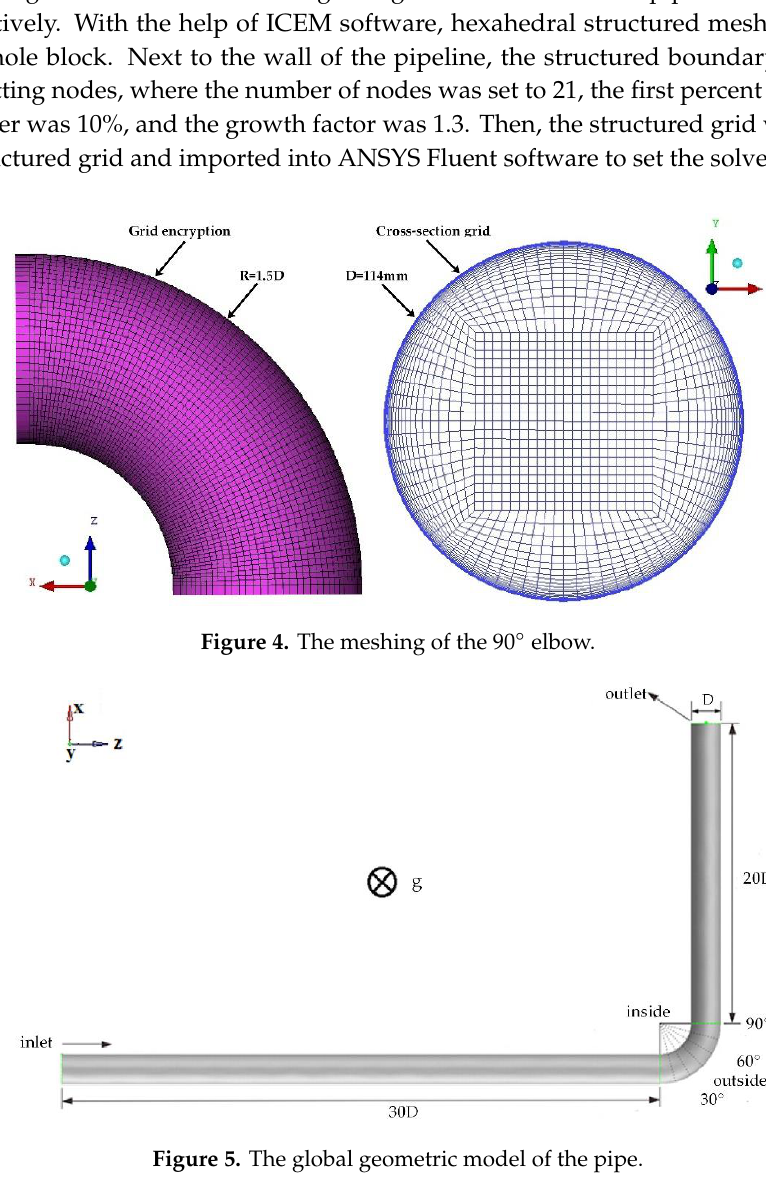
Figure 5. The global geometric model of the pipe.